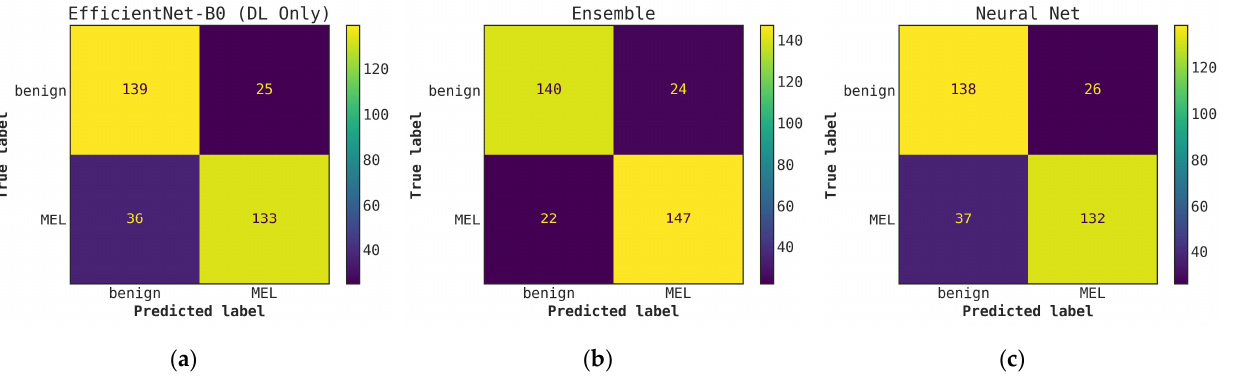
Figure A4. Illustrates a comparison of confusion matrices obtained using cascade generalization, utilizing the probability outputs of the EfficientNet-B0 model. ( a ) Confusion matrix for classification using only the EfficientNet-B0 model (DL-only, level-0); ( b ) Confusion matrix for classification utilizing the EfficientNet-B0 probability outputs and hand-crafted features, obtained through an ensemble of conventional classifiers (averaging); ( c ) Confusion matrix for classification using EfficientNet-B0 (level-0) probability outputs and hand-crafted features for the best conventional classifier, Neural networks. All confusion matrices are generated after applying a threshold of 0.5 to the models probability outputs to obtain the final predictions.